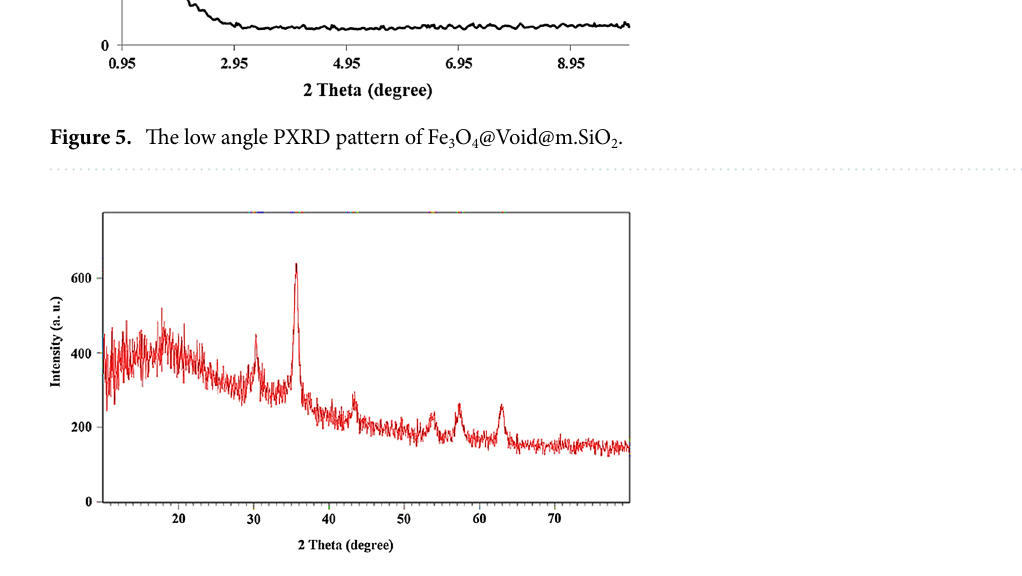
Figure 6. The wide-angle PXRD pattern of Fe 3 O 4 @Void@m.SiO 2